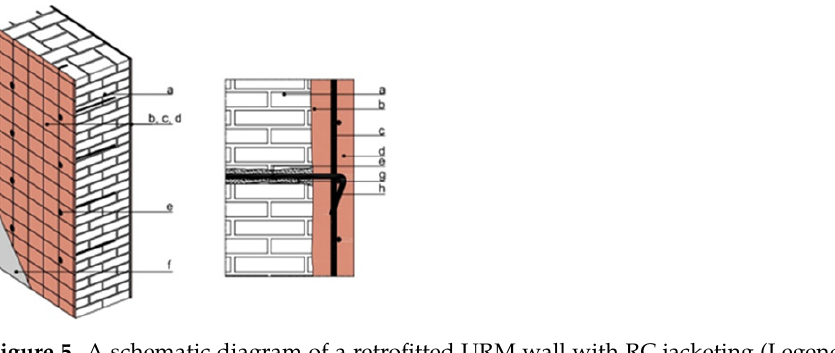
Figure 5. A schematic diagram of a retro fi tt ed URM wall with RC jacketing. (a) existing masonry wall; (b) first layer of concrete; (c) steel wire mesh; (d) second layer of concrete; (e) steel anchors; (g) a grouted hole; (f) cement-based plaster; and (h) a steel anchor with a 90-degree hook.